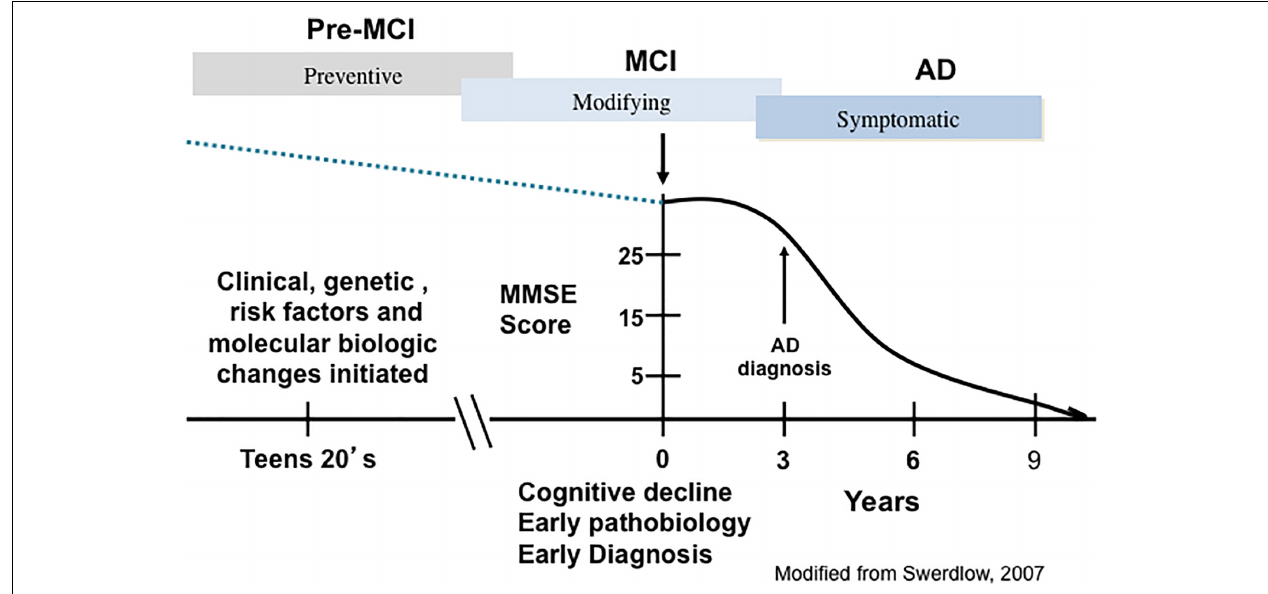
FIGURE 1 | A schematic illustration depicting the trajectory of the clinical and pathological progression of Alzheimer’s disease (AD). PreMCI, pre-mild cognitive impairment; MCI, mild cognitive impairment.